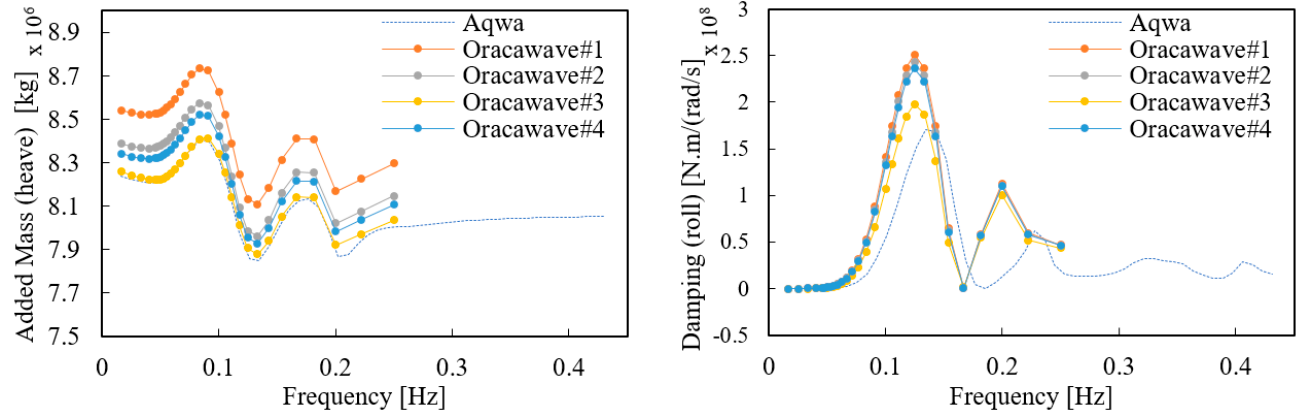
Figure 17. Six-column platform hydrodynamic result (heave and